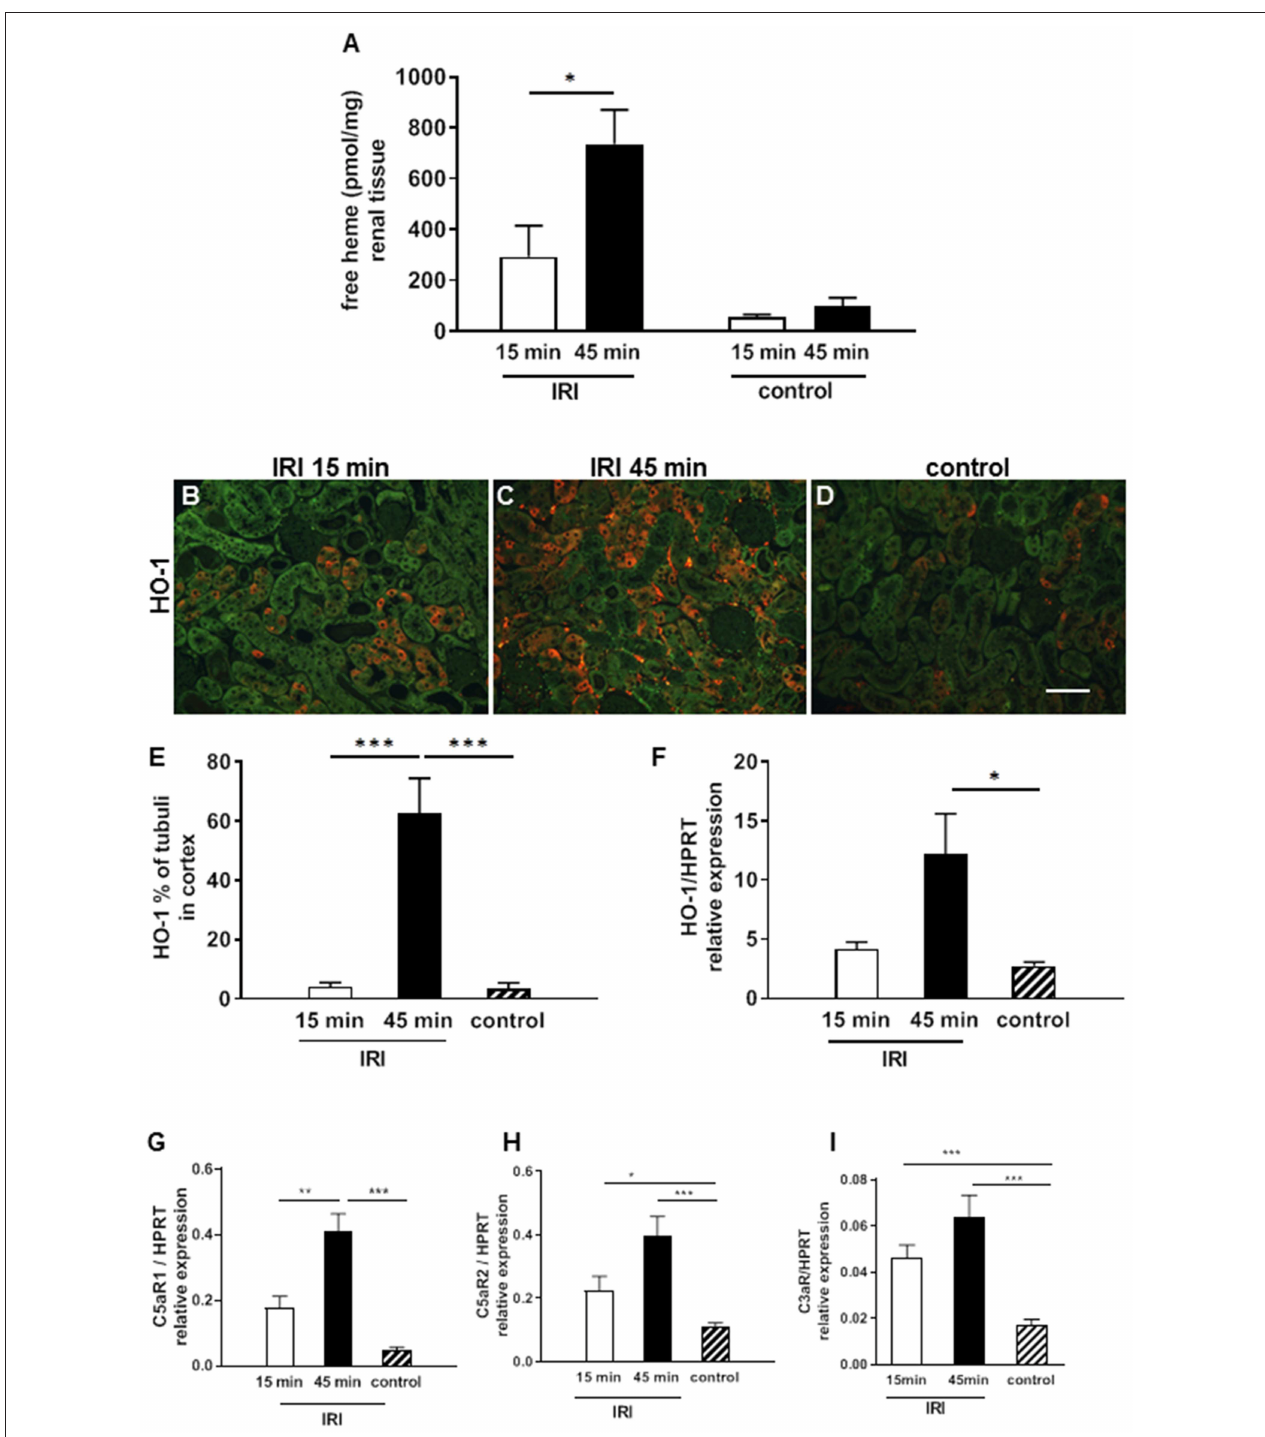
FIGURE 1 | Labile heme release and complement activation after IRI. In renal tissue labile heme was elevated after 2h in the 15min but even more in the 45min IRI model (A) . HO-1 mRNA expression increased significantly after 45min IRI (F) and also the expression of HO-1 protein on proximal tubular epithelial cells was significantly enhanced in the 45min IRI group ( B–E , bar: 100 µ m). The anaphylatoxin receptor C5aR1mRNA expression was significantly higher after prolonged ischemia time at 24h after IRI (G) . C5aR2 and C3aR showed enhanced mRNA expression after 15 and 45min IRI compared to controls but the IRI groups did not differ (H,I) n = 5 mice/group, one way ANOVA. * p < 0.05, ** p < 0.01, *** p <